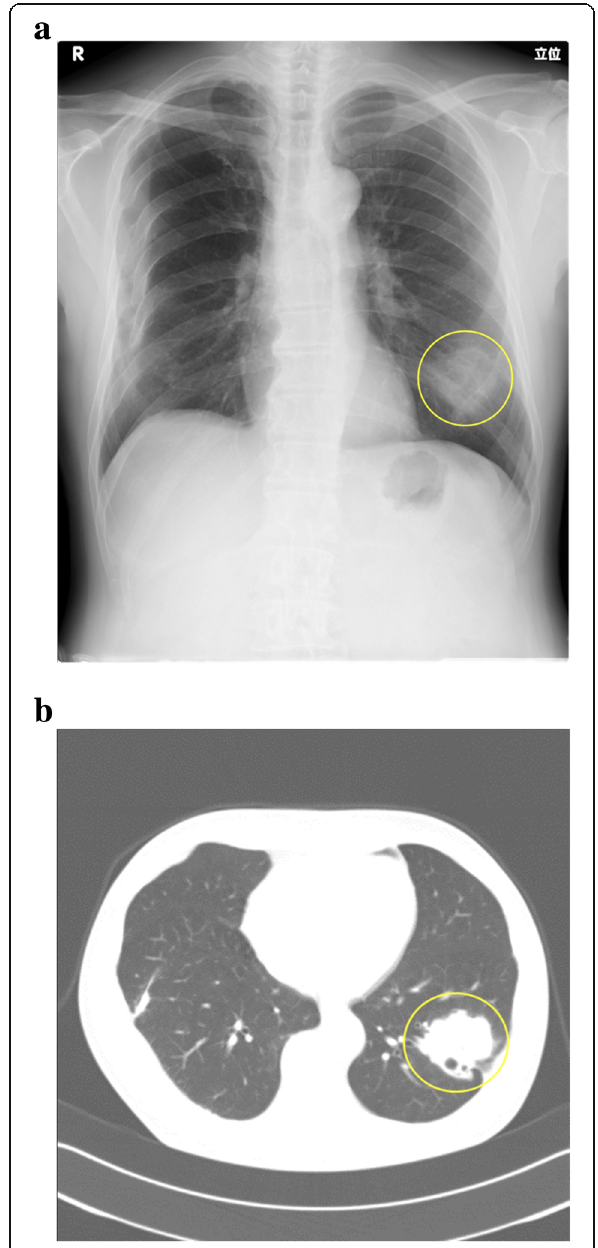
Fig. 1 a Chest X-ray shows a 50-mm mass in the left lower field (yellow circle). b Chest CT scan shows a 47-mm tumor in the left lower lobe lateral basal segment (yellow